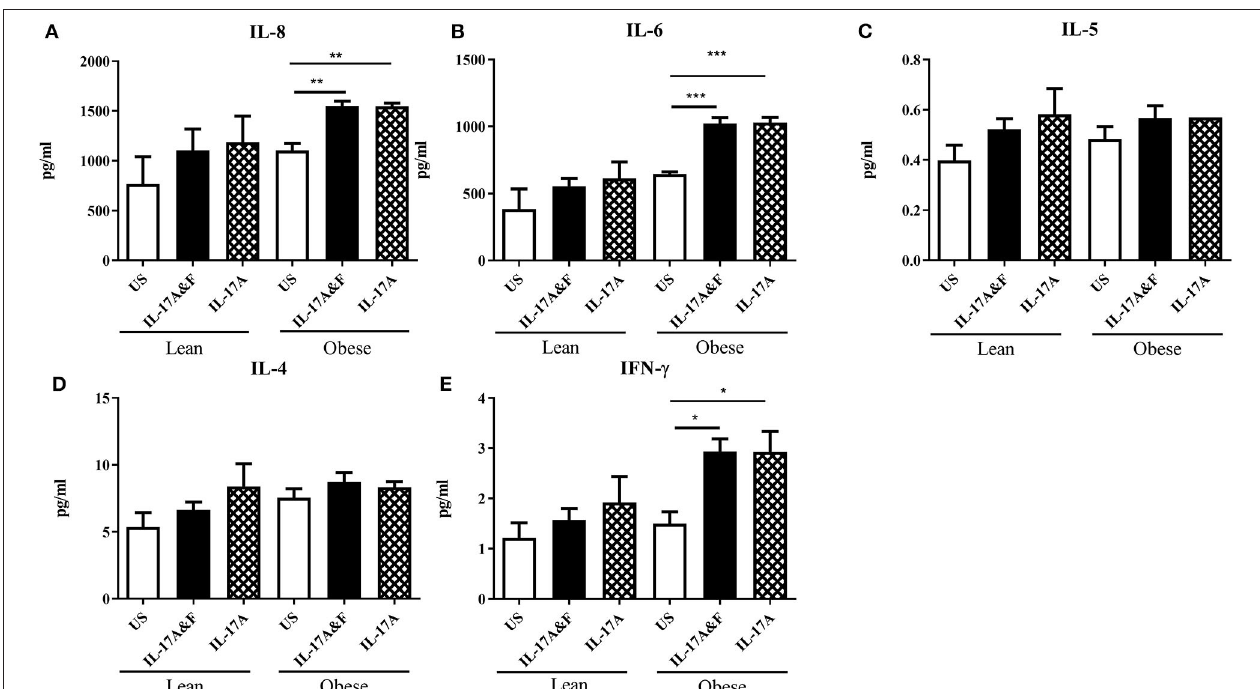
FIGURE 5 | Stimulation with IL-17A&F and IL-17A alone induces changes in inflammatory cytokine profiles in adipocytes from lean and obese subjects. A multiplex assay was used to measure the levels of inflammatory cytokines: IL-8 (A) , IL-6 (B) , IL-5 (C) , IL-4 (D) , and IFN- γ (E) secreted by mature adipocytes after 48h stimulation with IL-17A & F combination or IL-17A alone. One independent experiment preformed per subject. n = 4 lean subjects, n = 3 obese subjects, One-way ANOVA, Mean ± SE; * P < 0.05, ** P < 0.01, *** P < 0.001.